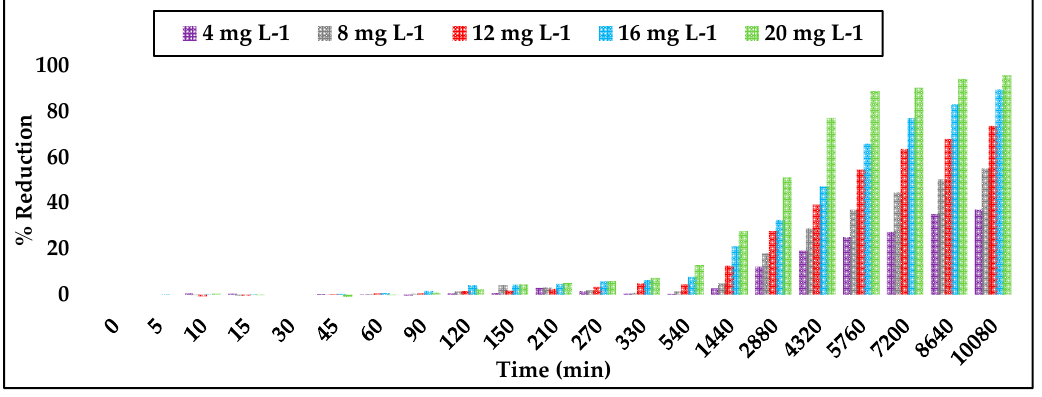
Figure 5. Evolution of simazine reduction over time with different doses of GAC. Experimental conditions: [Simazine 0 ] = 0.7 mg L − 1 ; [GAC] = 4, 8, 12, 16 and 20 mg L − 1 ; pH 0 6.7; T = 25 °C.